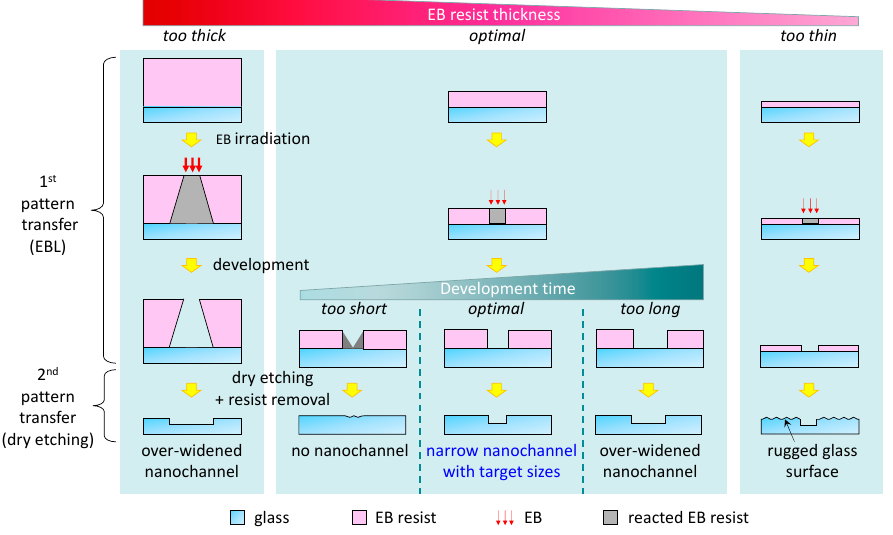
Figure 1. Schematic of the difference in structures of nanochannels fabricated under different conditions of varying EB resist thickness and development time.